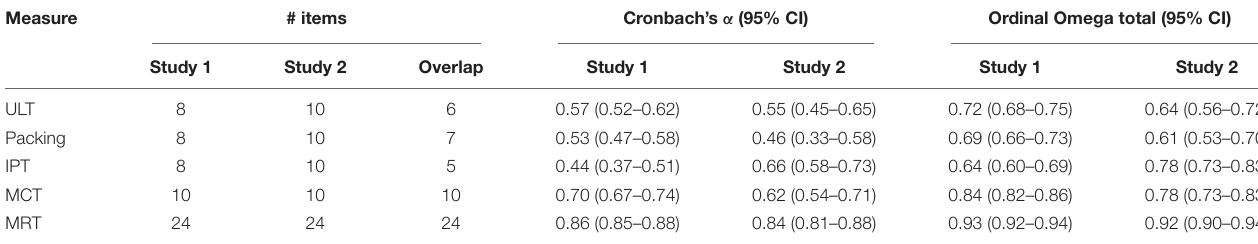
TABLE A2 | Number of items by test version and respective reliability estimates.